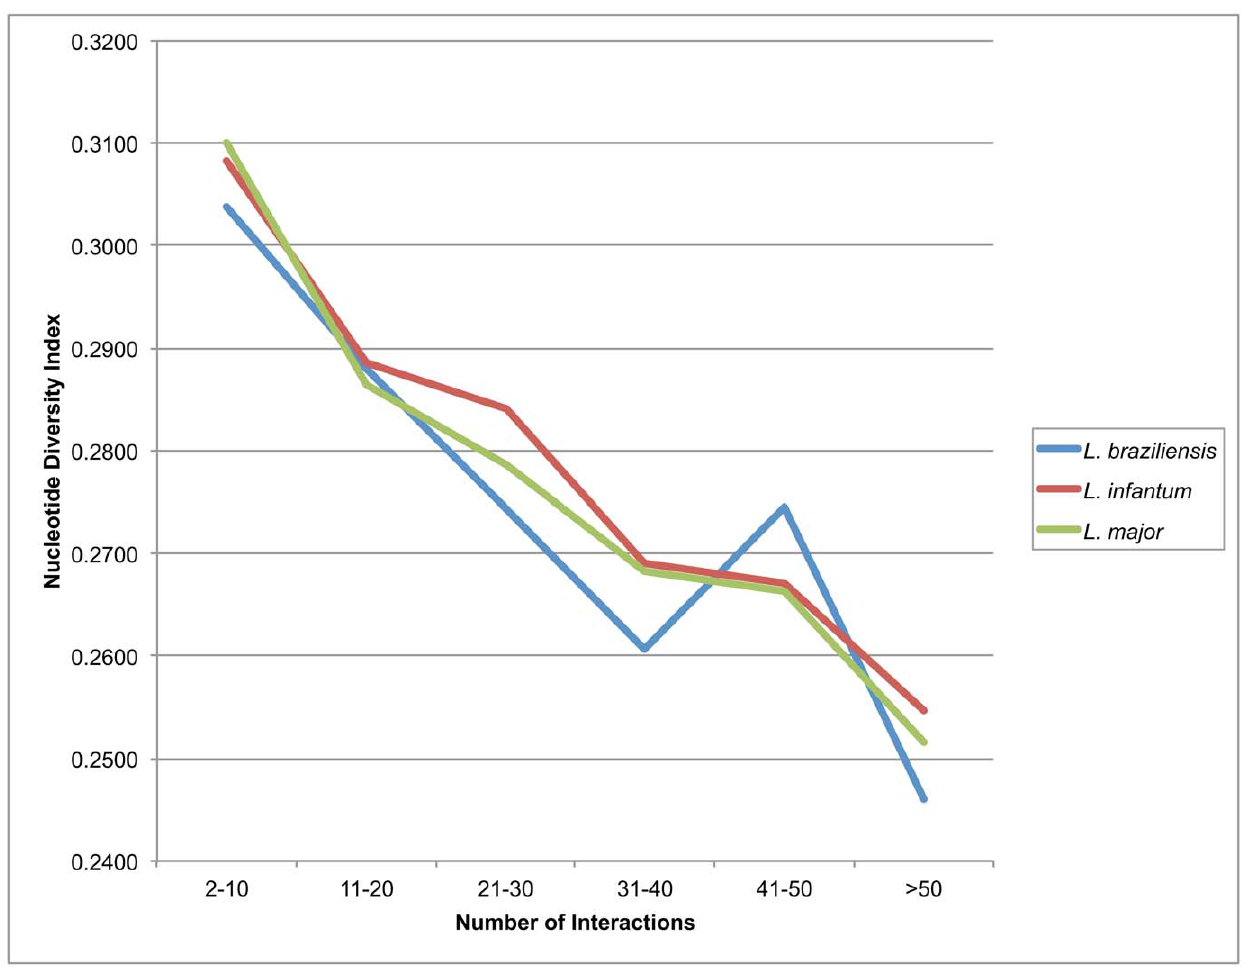
Figure 3. Degree versus diversity analysis. Graph of median of Nucleotide Diversity ( p ) measure (Y axis) versus Degree range (X axis) of three PPIs.